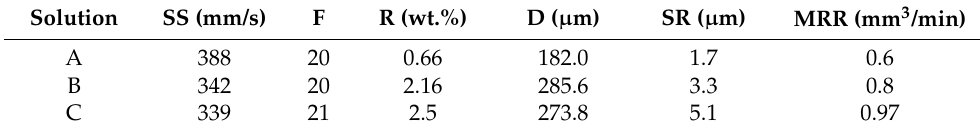
Figure 14. 2D Pareto optimal solutions for SR and MRR. Table 9. Optimal laser micromachining parameter and GnP reinforcement ratio .